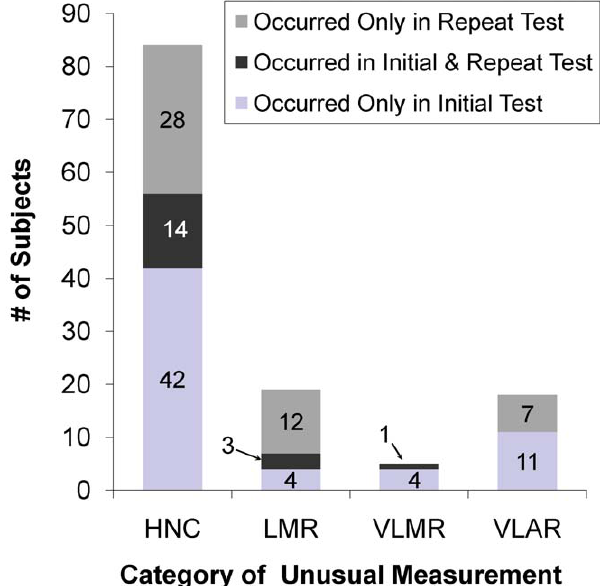
Figure 1. Number of subjects with unusual IFN- c measure- ments. The number of subjects with unusual IFN- c measurements categorized as High Nil Concentration ( HNC ), Low Mitogen Response ( LMR ), Very Low Mitogen Response ( VLMR ), and Very Low Antigen Response ( VLAR ) that occurred once (dark gray bars) or more than once (light gray bars) among 1,725 subjects who had 5,309 QuantiFERON-TB Gold and QuantiFERON-TB Gold In-Tube Tests performed. subjects with VLAR on simultaneously performed QFT-G or